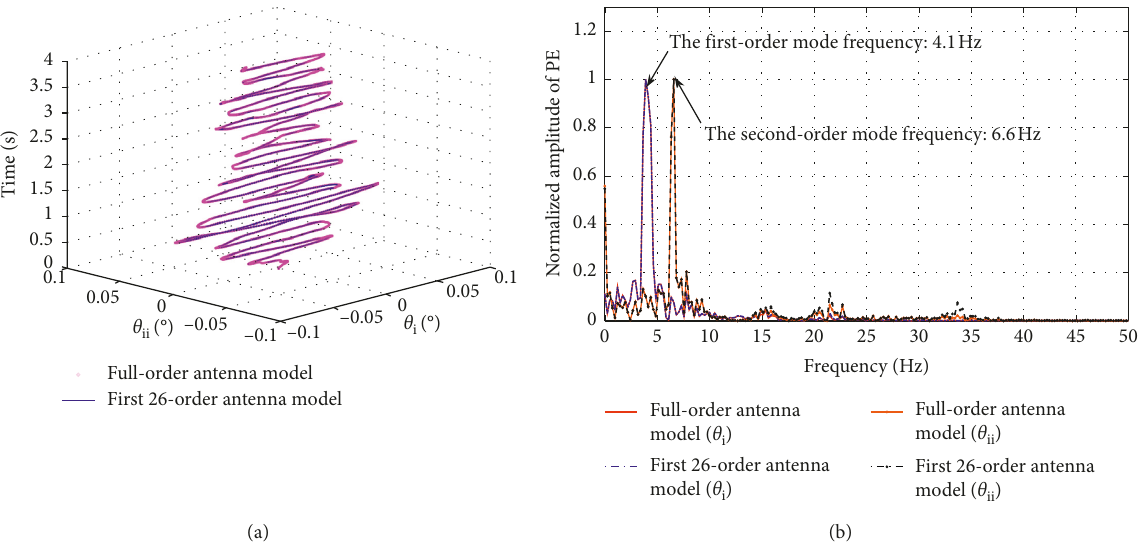
Figure 5: PEs under wind forces in the (a) time domain and (b) frequency domain.